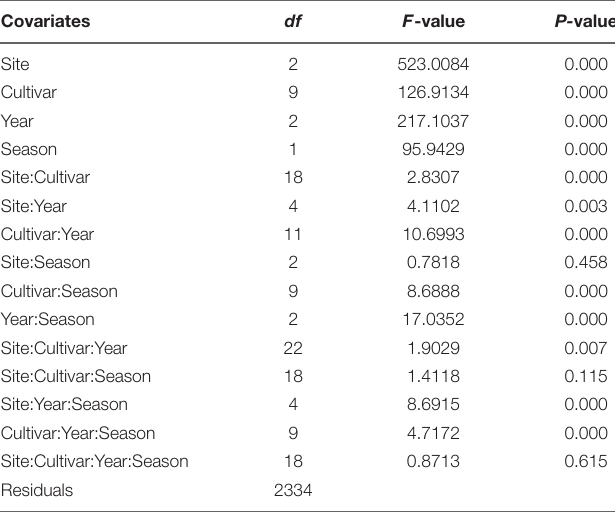
TABLE 3 | Mix model ANOVA results of the sum of mean number of eggs per pair of codling moth and covariates (year, apple cultivar, position of eggs on apple [calyx, stem, and lateral sites], and season [early and